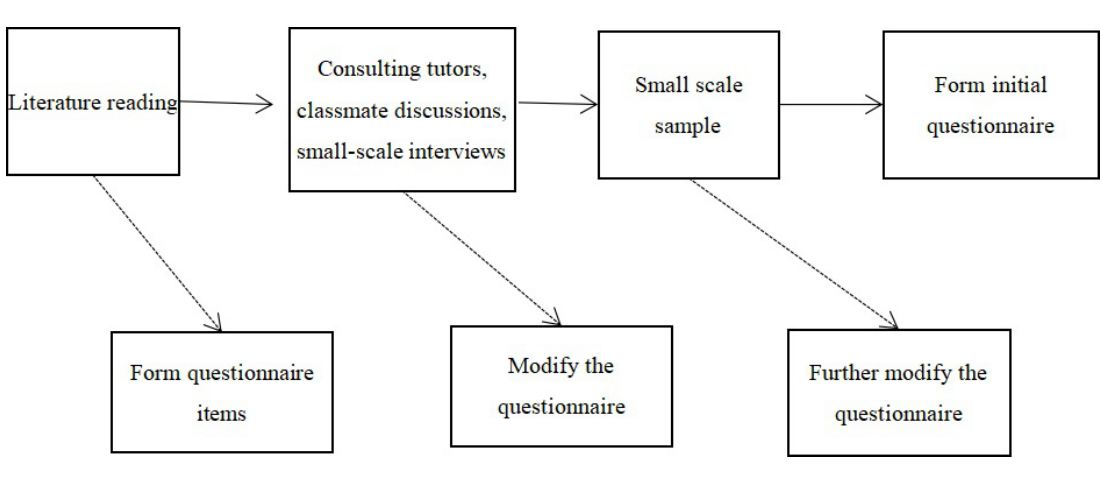
Fig. 6 Questionnaire survey